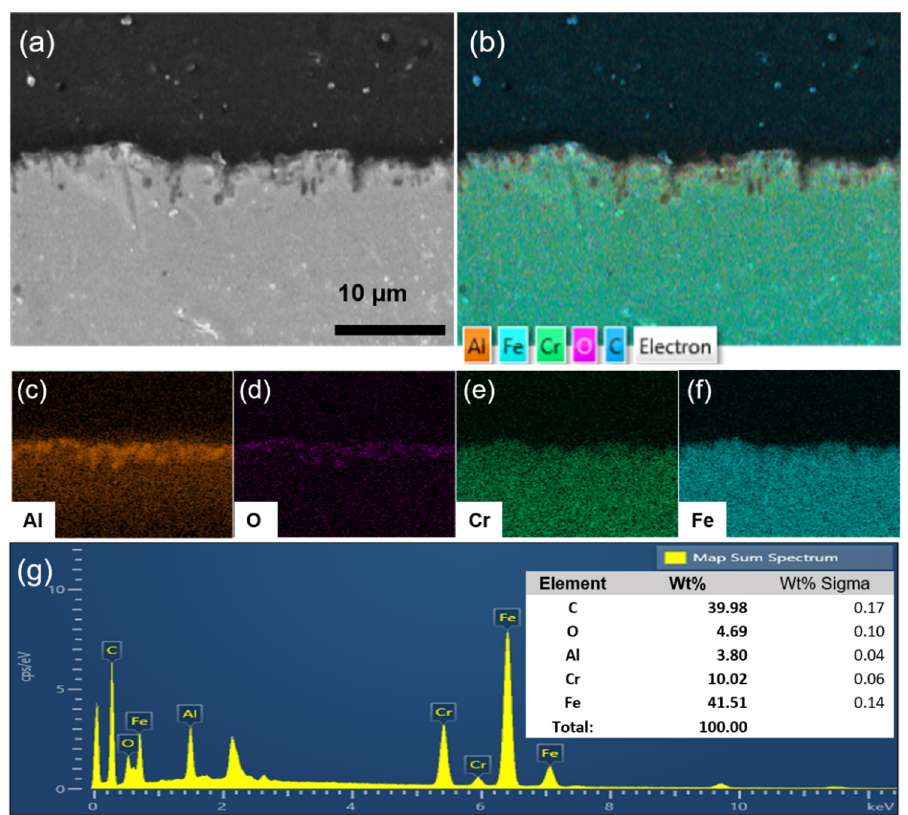
Figure 3. SEM images of the bare γ -Al 2 O 3 intermediate layer on the STS-444 substrate ( a ). Elemental mapping profiles of γ -Al 2 O 3 intermediate layer bearing STS-444 substrate ( b ) and each element ( c – f ). ( g ) EDS spectra of the γ -Al 2 O 3 intermediate layer on the STS-444 substrate.